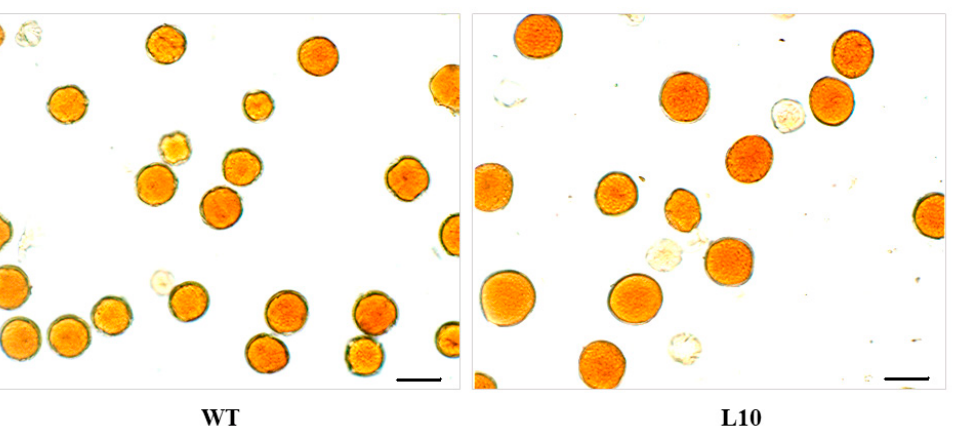
Figure 9. Average seed boll weight in transgenic tobacco plants with VlvSTS gene (mg). Seed boll weight in control plants was taken as 100%. WT—nontransformed plant; L10 and L23–T0 trans- genic plant lines; L10-2, L10-6, L10-8, L10-9, L23-5, L23-6, L23-8, L23-9—T1 transgenic plant lines. ** Statistically significant at Mann-Whitney test ( p < 0.01). 3. Discussion Stilbene synthase involvement in rendering plants resistant to various pathogens was shown by many authors [1–5,7–10]. It is related to the synthesis of various stilbenes in plants, and among them resveratrol, which is an antioxidant and phytoalexin. In this study, we analyzed transgenic tobacco plants transformed with a stilbene synthase gene VlvSTS from thehybrid grape Vitis labrusca x Vitis vinifera L. cv. Isabel under the control of the double promoter CaMV 35SS. The gene expression was various in different transgenic lines, as shown by real-time RT-PCR. For the first time it was shown that plants expressing the VlvSTS gene had enhanced resistance to the bacterial pathogen E. carotovora subsp. carotovora В 15. The study evaluated three lines of transgenic plants with a high, medium, and low VlvSTS expression (lines L10, L23 and L24). Interestingly, resistance correlated with the expression level of the stilbene synthase gene. In plants with a higher gene